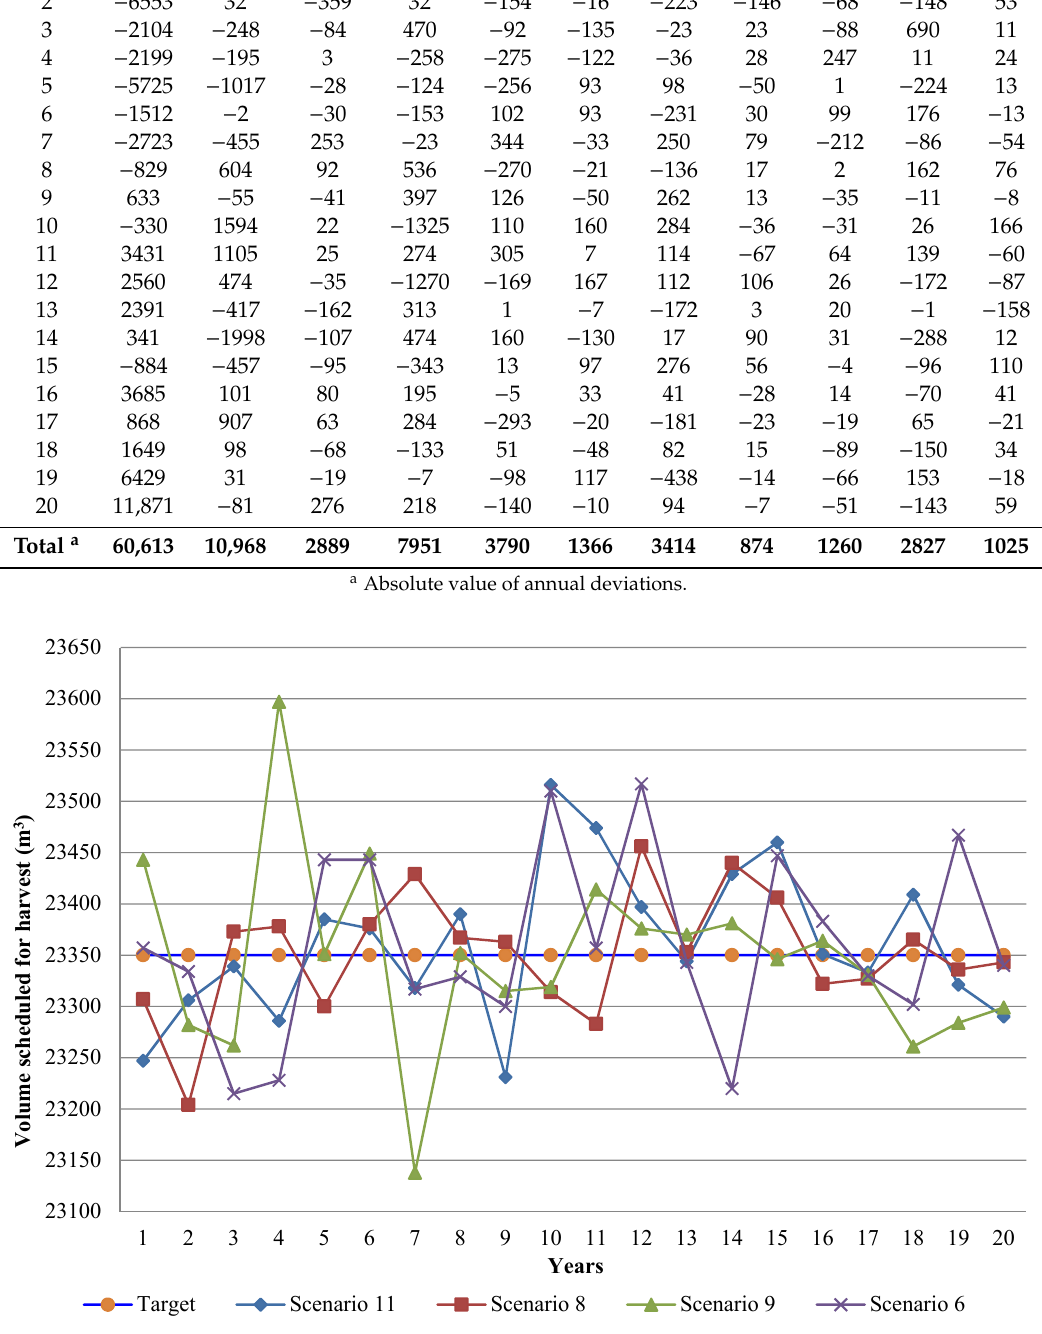
Figure 3. A comparison of the scheduled volume achieved using the linear regeneration model.